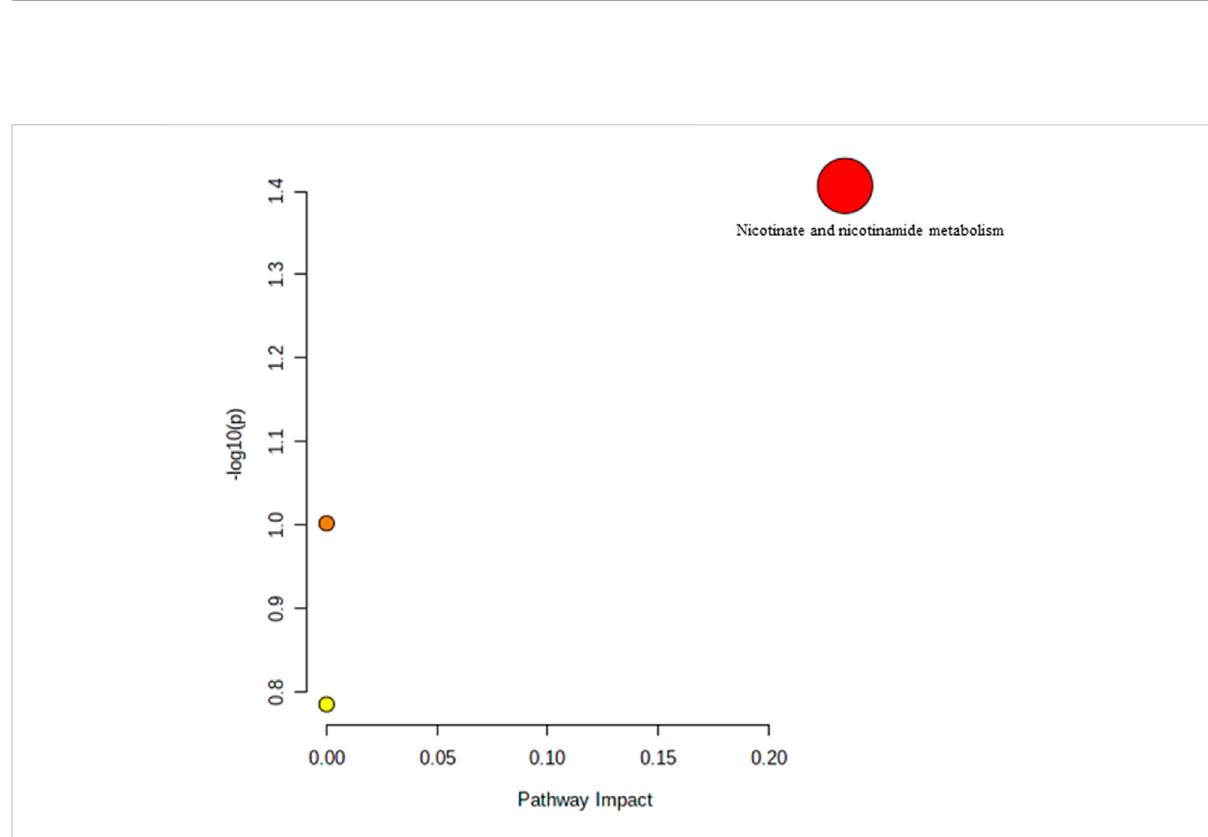
FIGURE 5 Biochemical pathway analysis of metabolites pro fi led for YC vs.